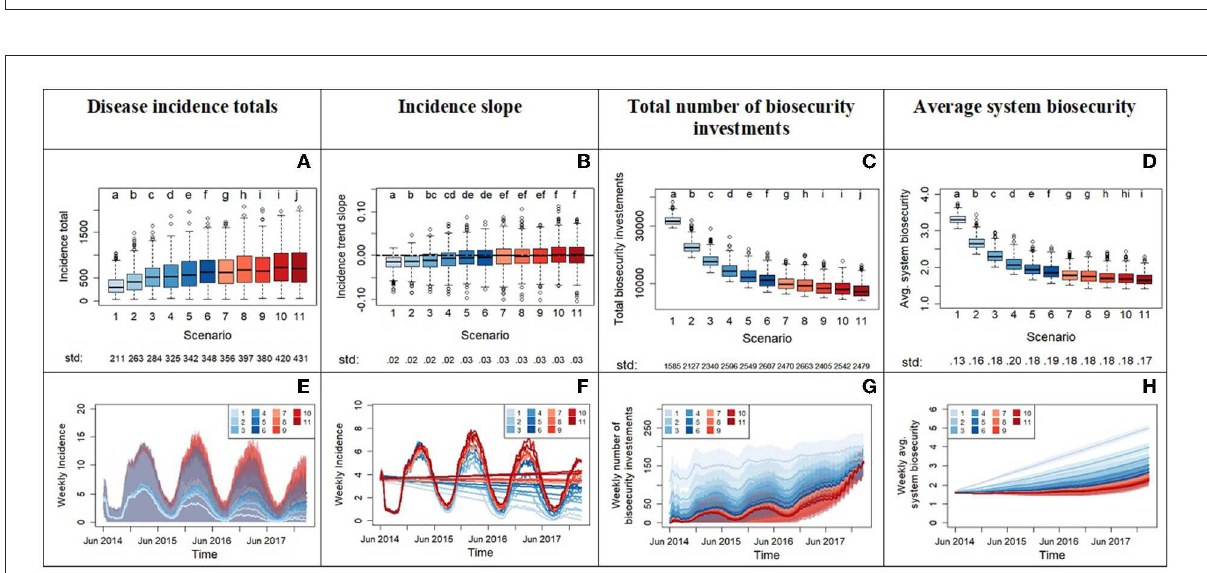
FIGURE6 Outputs from experiment 2 comparing the system across a gradient of increasing tolerance with scenario 1 having the lowest tolerance and scenario 11 the highest. This is done by increasing the parameter x0, which represents the threshold in number of infected premises in the neighborhood of a producer before triggering the producer’s investment in biosecurity. The top row displays the box plots of system variables (y axis): disease incidence totals (A) , incidence slope from time series (B) , total number of biosecurity investments (C) , and average system biosecurity (D) . The x axis reports the different scenarios. We applied a Bonferroni adjustment and test each hypothesis at level alpha = 0.0045. Letters on top of the box plots report results from pairwise distribution comparisons across scenarios. Distribution not sharing any letter are different by the two-sample Kolmogorov-Smirnov test at the alpha level of significance. The standard deviation value of each distribution is printed below the box-plot x axis. The bottom row of the figure (E–H) displays time series with weekly frequency for the variables. The colored shades show the variability provided by the Monte Carlo replicates. Panel (F) zooms into the average weekly incidence lines of panel (E) and includes the linear